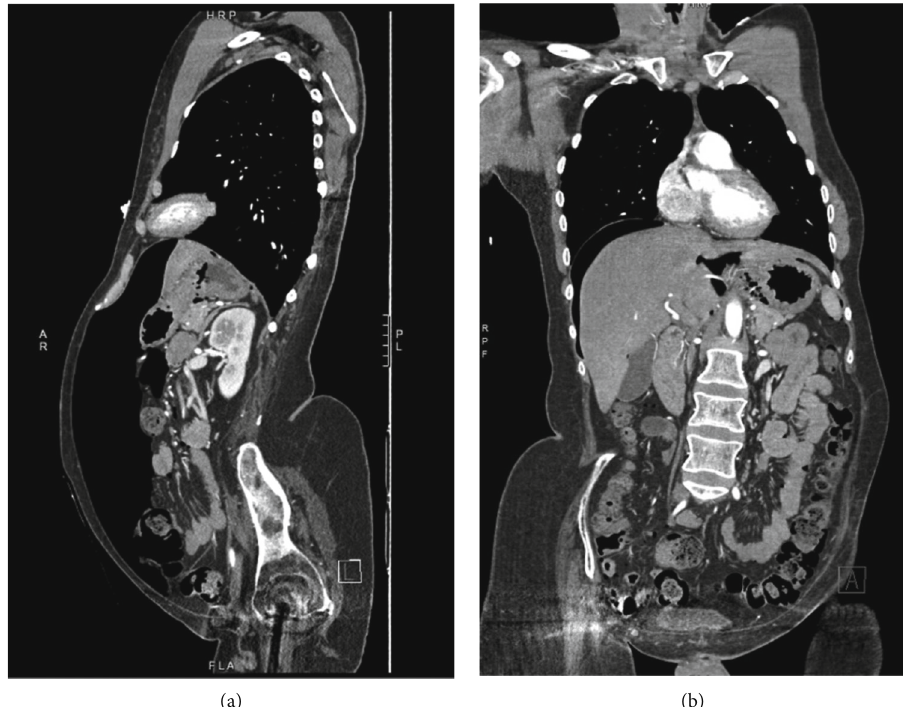
Figure 1: Computed tomography (CT) scan of the chest, abdomen, and pelvis; sagittal view (a) and coronal view (b).